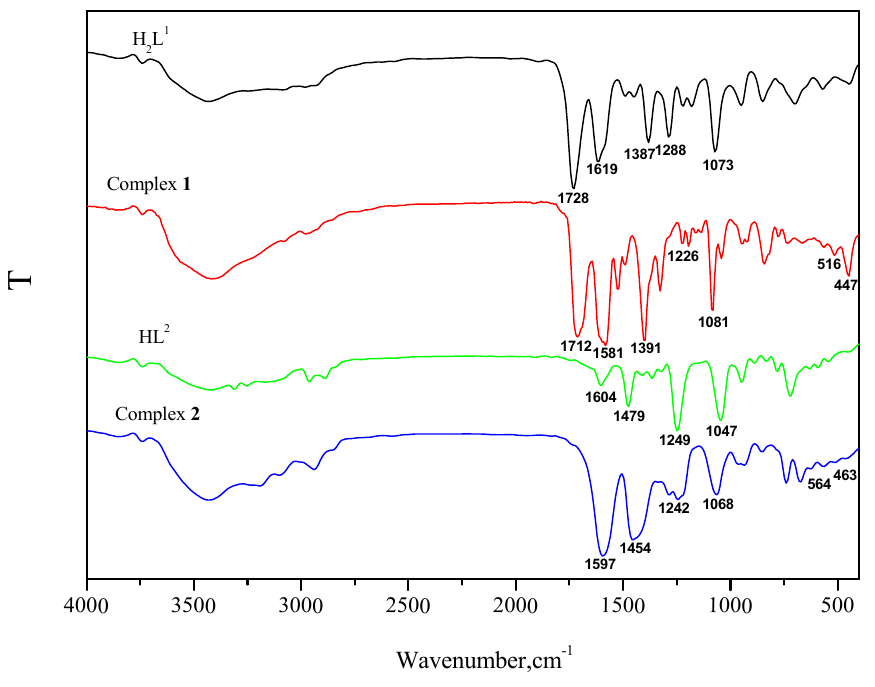
Fig. 1 The FT-IR spectra of the ligands and their complexes 1 and 2 (cm − 1) Figure 1. The FT-IR spectra of the ligands and their complexes 1 and 2 (cm − 1)